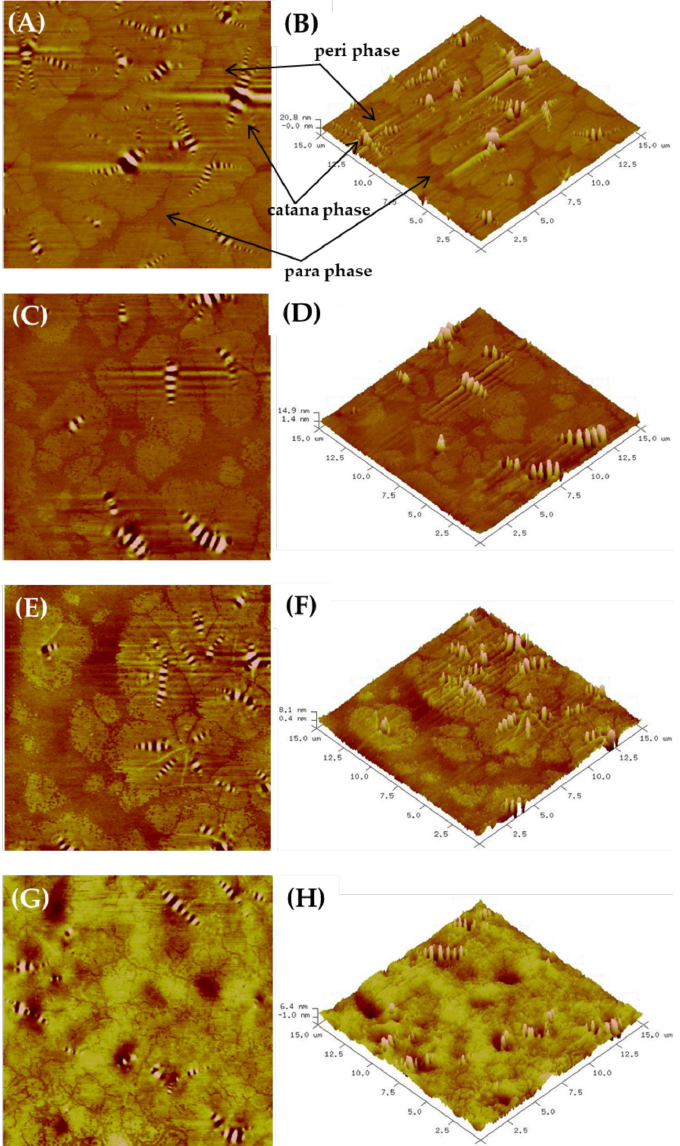
Figure 6. AFM topographical images of the control bitumen ( A , B ), bitumen modified with biopolymer ( C , D ), bitumen modified with biopolymer in presence of crosslinking agent ( E , F ), and PMB ( G , H